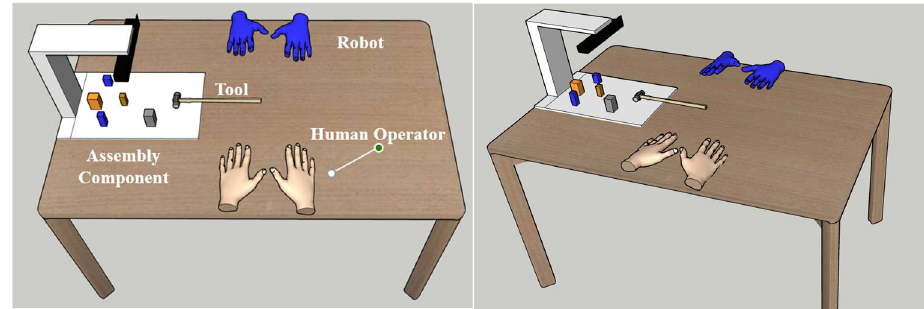
Figure 4. Design Experiment on the Previous Work [36].